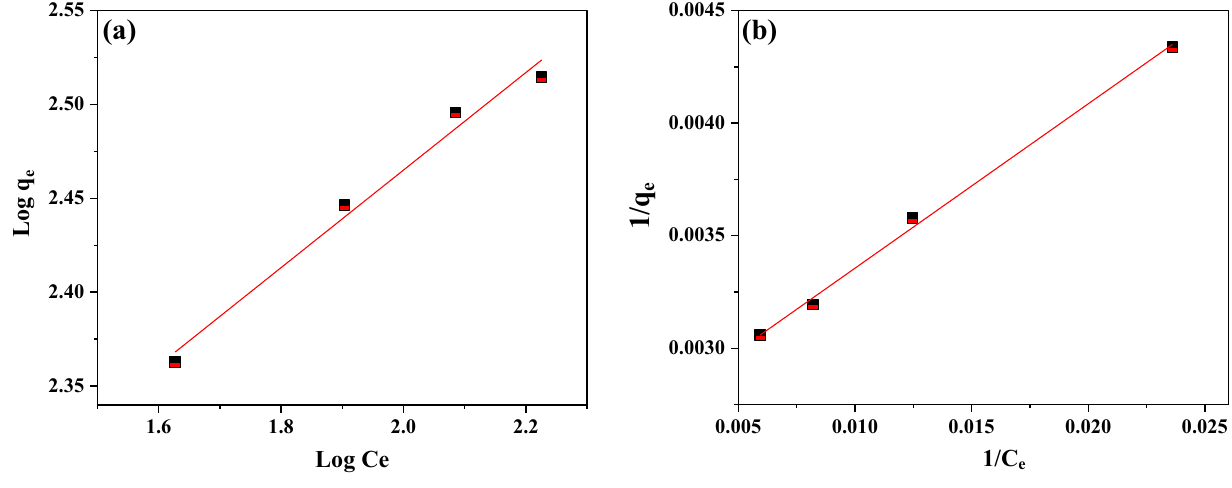
Fig. 5 Freundlich ( a ) and Langmuir ( b ) isotherm diagrams for activated carbon on red cationic dye removal efficiency 14 Table 4 Langmuir and Freundlich absorption isotherm